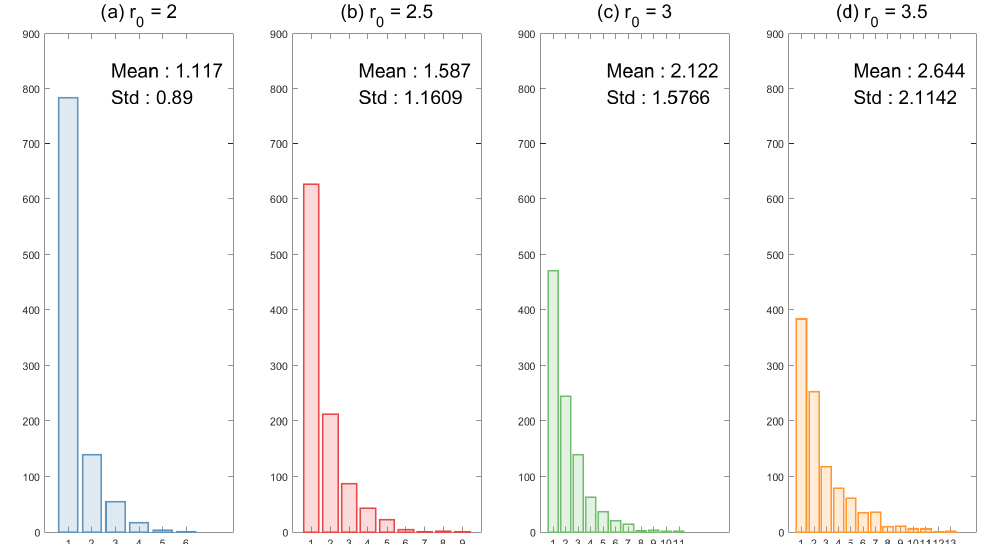
Figure 6. Sensitivity analyses for the distributions of R 0 are shown under different epidemic parameters: the top panels show the impact of the baseline transmission rate β 0 and the bottom panels show the impact of the effective radius r 0 (these results are under